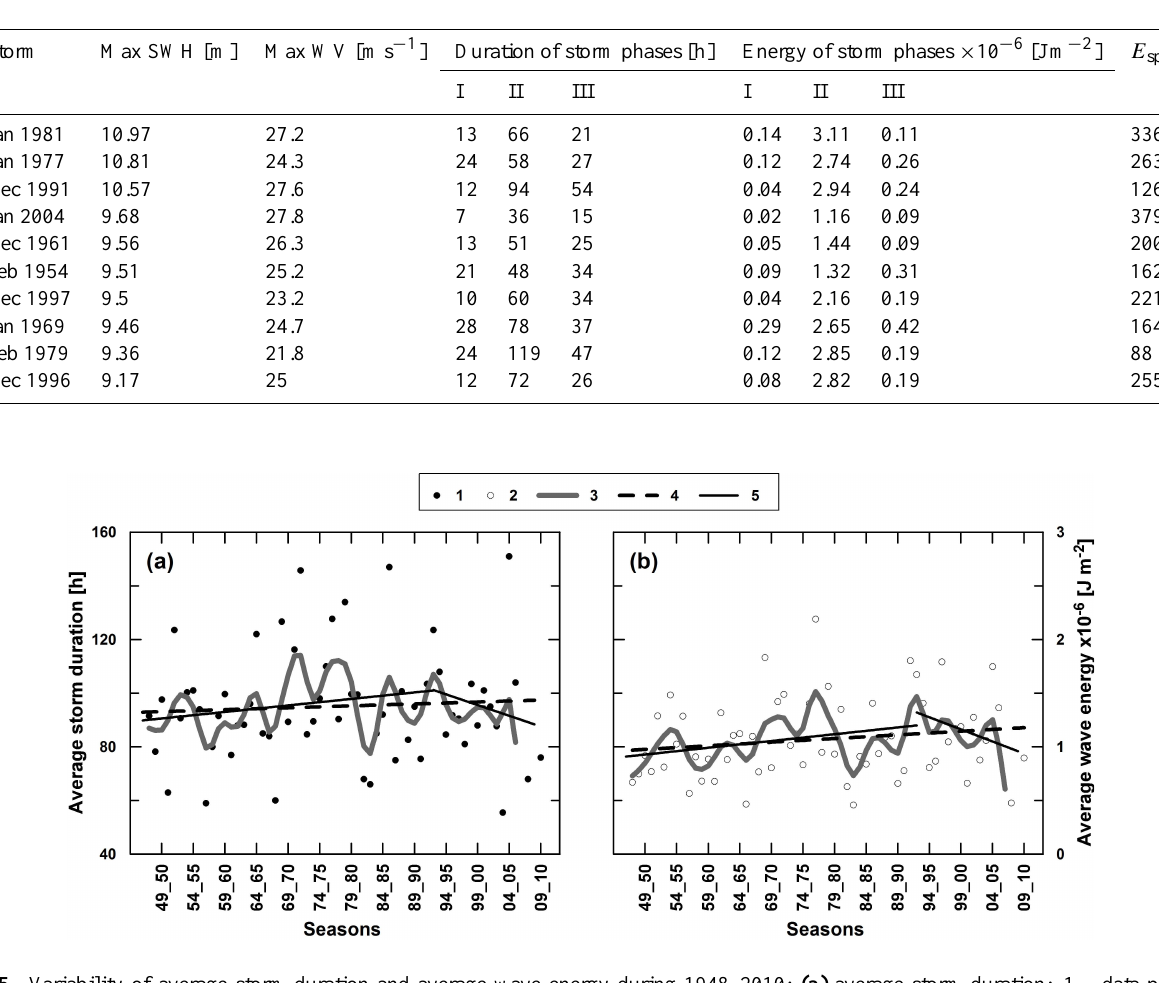
Table 3. The ten most severe storms that occurred during 1948–2010, ranked according to significant wave height maxima, and their properties; SWH – significant wave height, WV – wind velocity, E spf – specific wave energy.